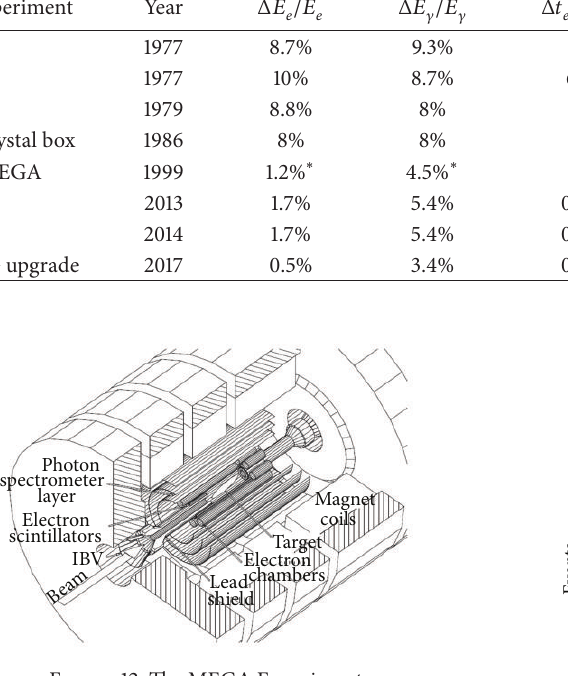
Figure 12: The MEGA Experiment.